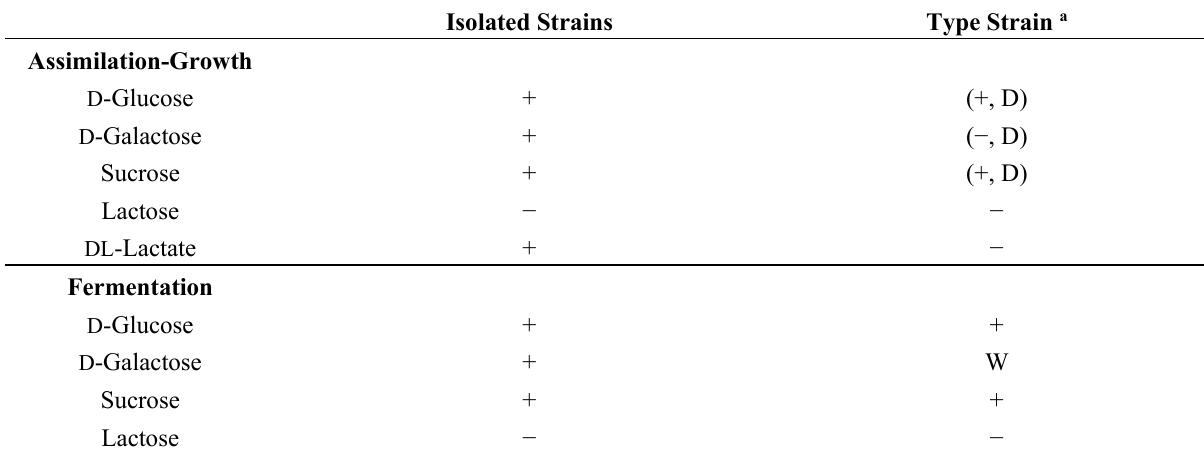
Table 2. Some physiological characteristics of the M. guilliermondii strains studied in this